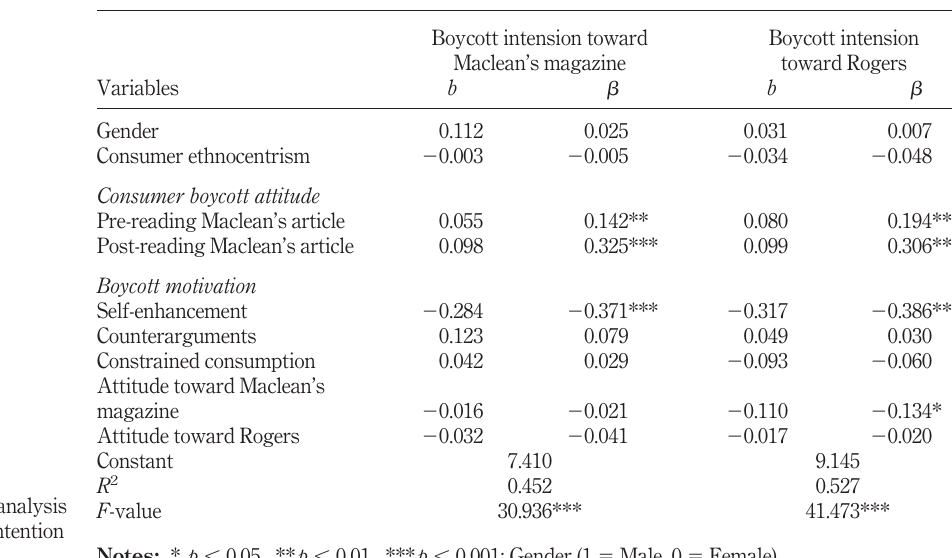
Table III. Regression